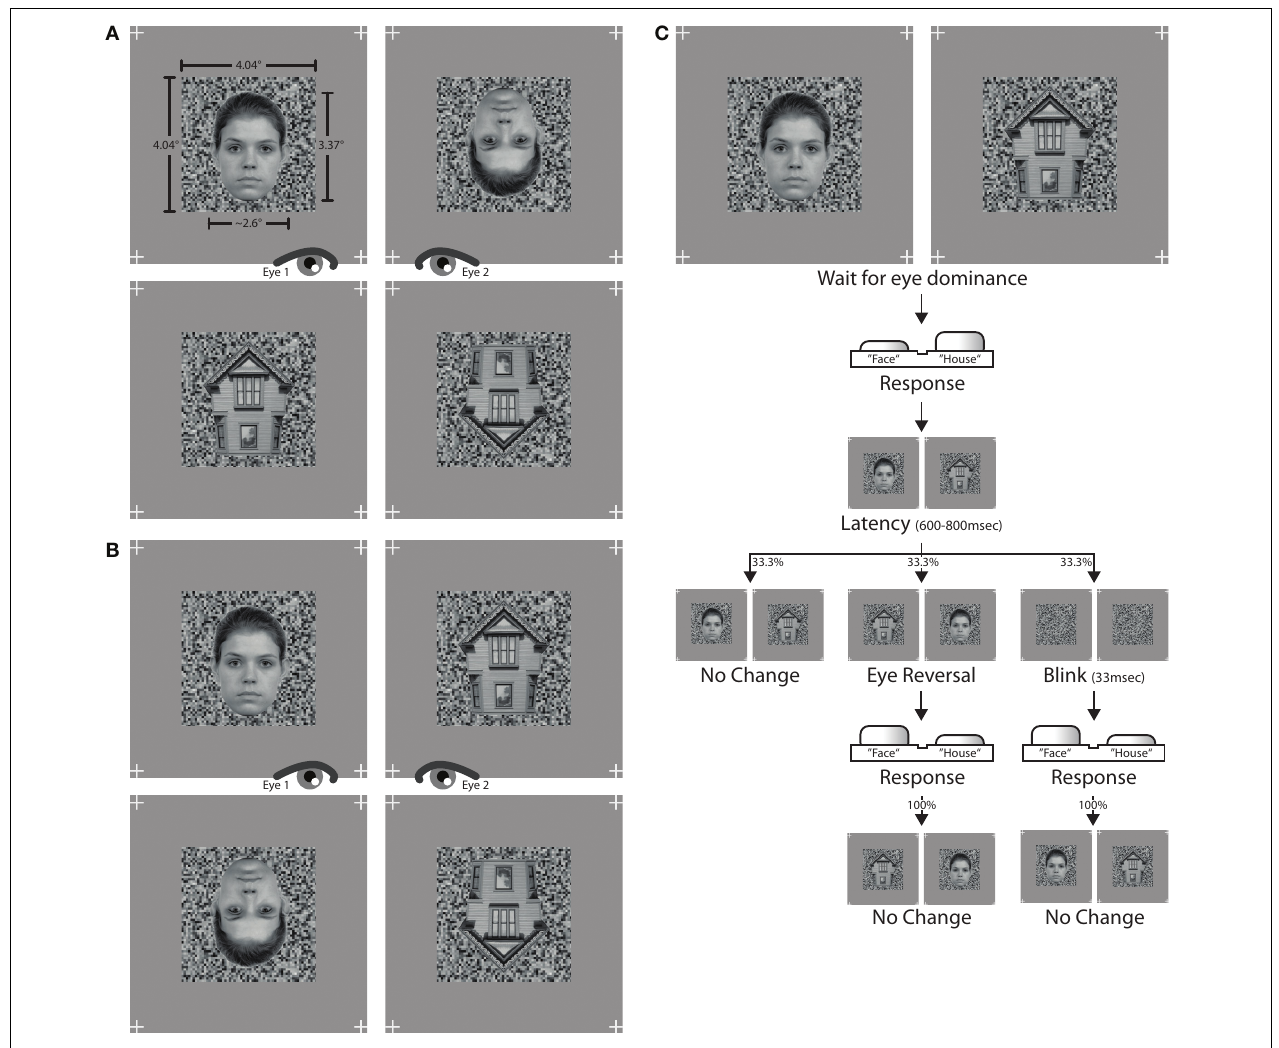
FIGURE 1 | Stimuli and trial. The left panel shows the stimulus combinations used in (A) experiment I and (B) experiment II. The assignment of stimulus to eye altered over the course of an experiment. The right panel (C) depicts the trial sequence used in both